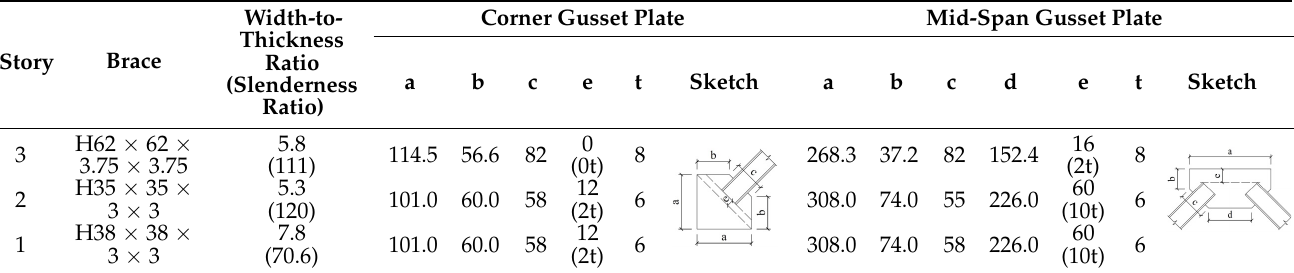
Table 6. Material-property-test results.